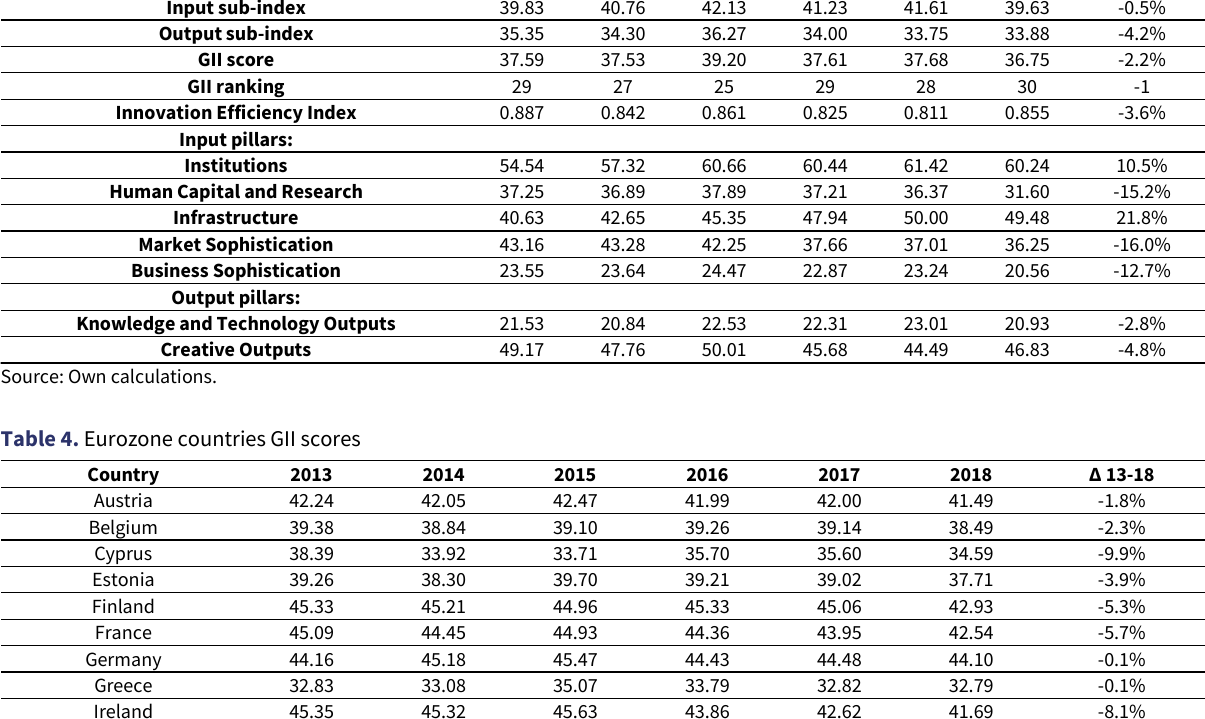
Table 3. Portugal ’ s GII ranking and scores Variable